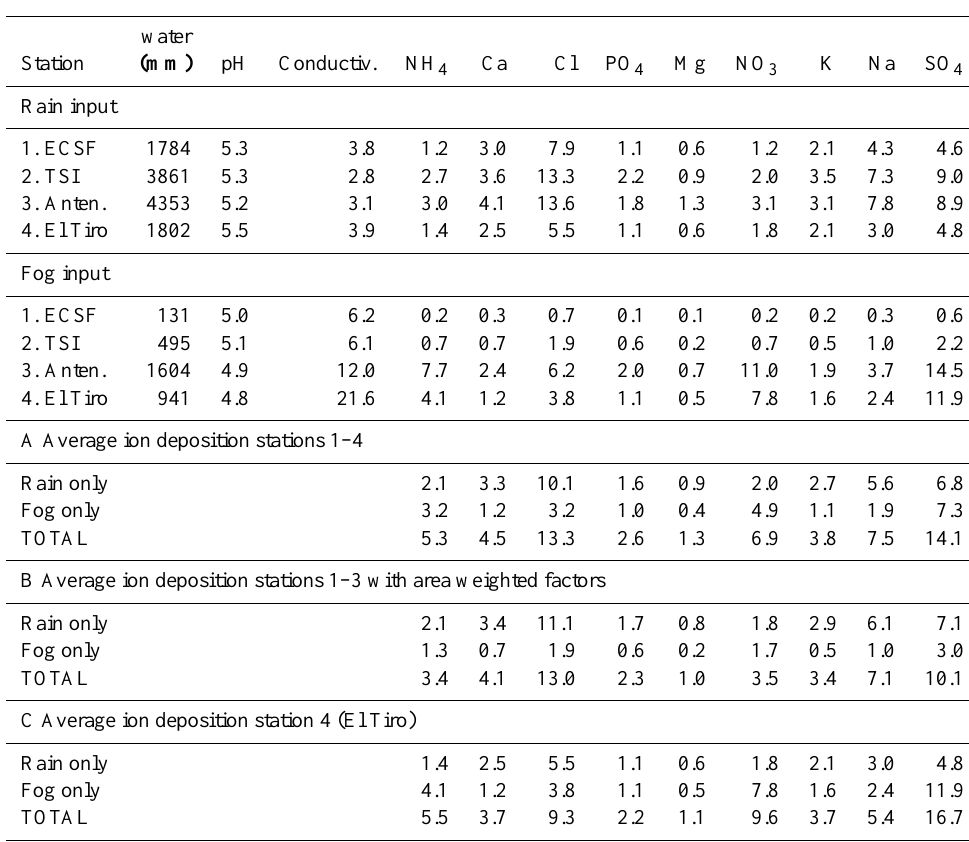
Table 3. Average annual precipitation (mm), pH, conductivity ( µ S/cm), and ion deposition rates (kg/ha)